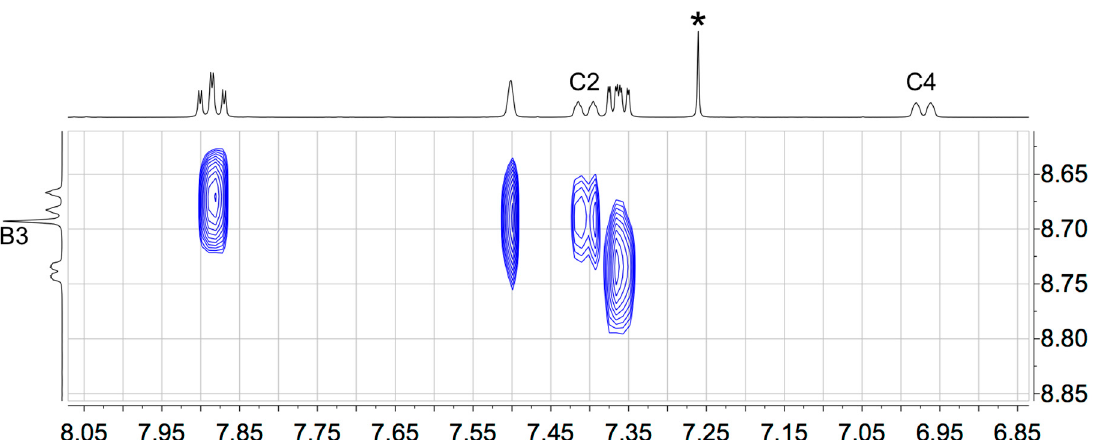
Figure 2. Part of the NOESY spectrum of compound 3, showing the cross-peak between the signals for H B3 and H C2 .